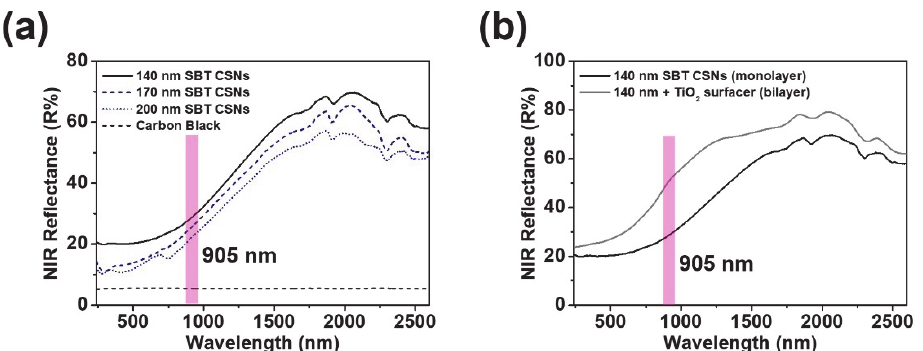
Figure 11. UV-VIS-NIR reflection spectra of ( a ) single coatings of various-sized SBT CSN- and carbon black-based paints on glass substrates and ( b ) 140 nm SBT CSN-based paint monolayer and bilayered system consisting of 140 nm SBT CSN-based paint and TiO 2 surfacer (pink mark: 905 nm wavelength region). Table 3. NIR reflectances of SBT CSN-based paint in monolayered and bilayered systems at 905 nm a . Base Material (Layer System)